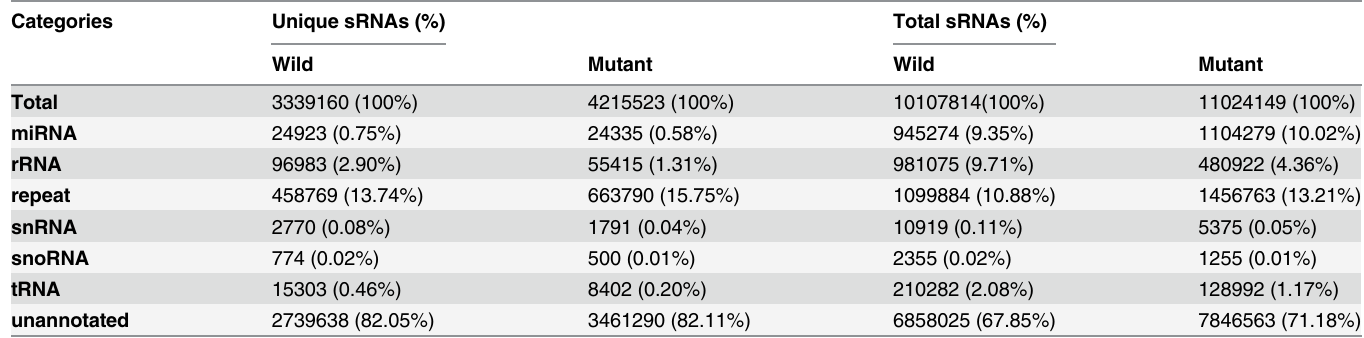
Table 4. Classification of annotation sRNAs.